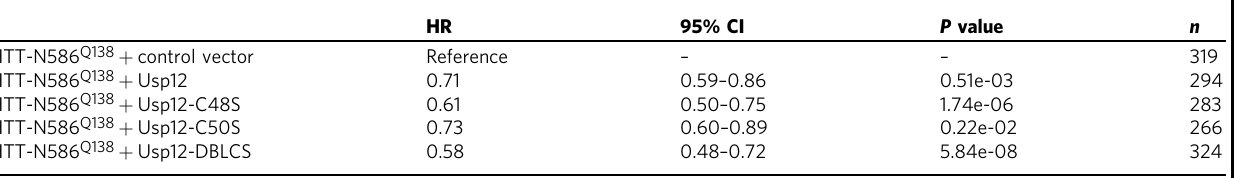
Reference = reference group for statistical analysis HR hazard ratio, n number of neurons, CI con fi dence